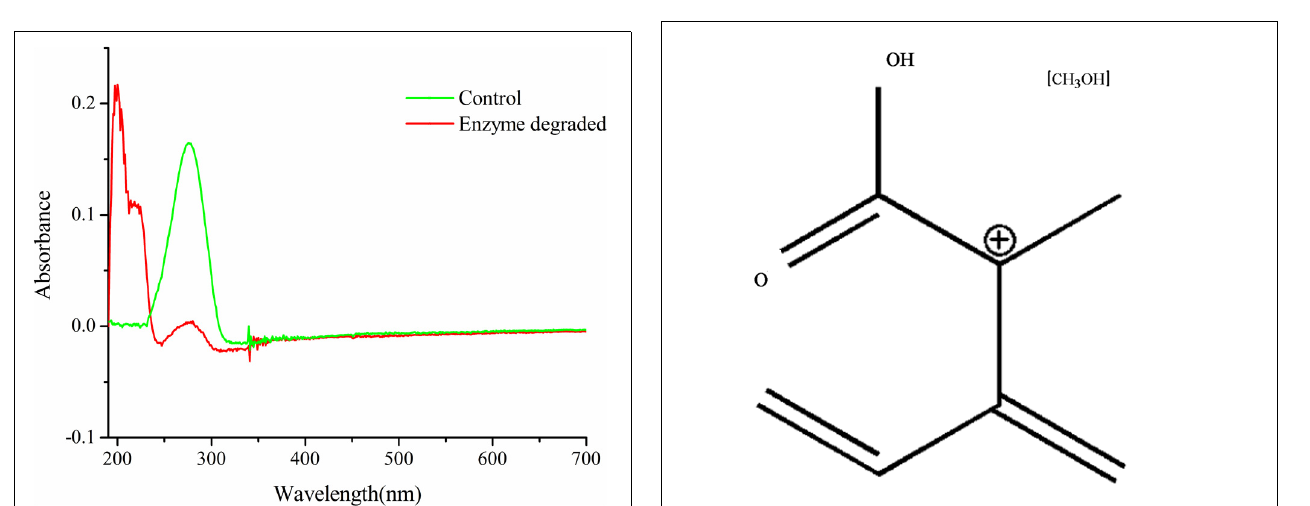
FIGURE 7 | The spectrum of the response result reactions with patulin and PPL.